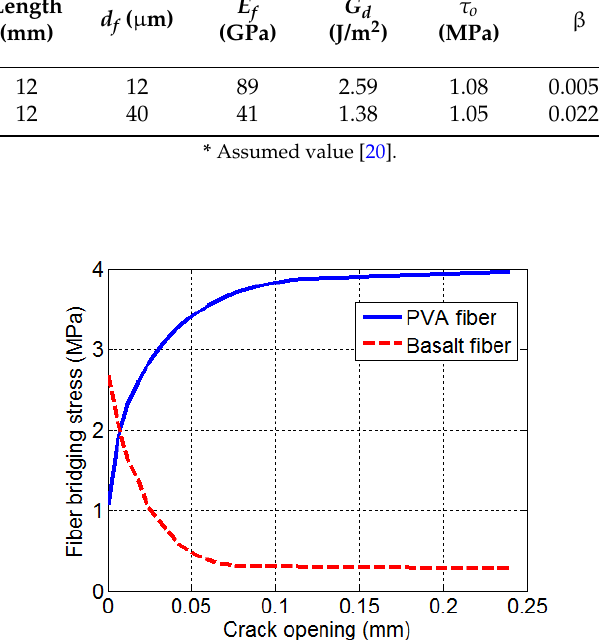
Table 7. Micromechanics parameters used as model input.